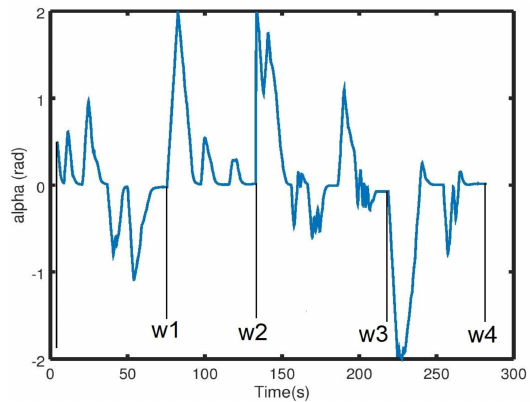
Figure 11. The variation over time of the angle between the robot’s position and the given